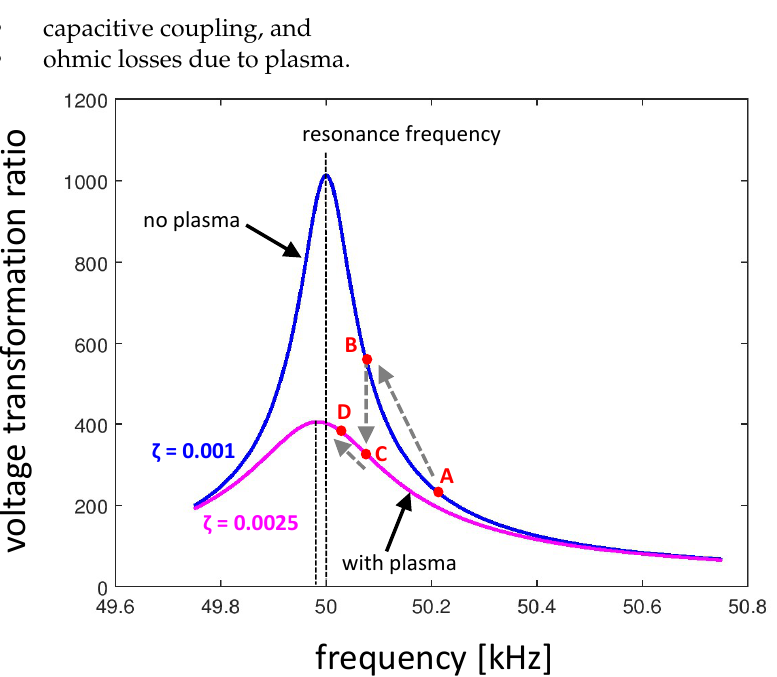
Figure 2. Trajectory of the working point of the RPT on the resonant curves during plasma